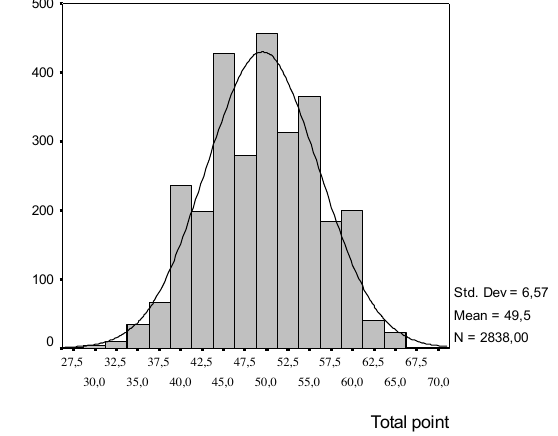
Figure 1 Total score distribution of knowledge levels of the students about